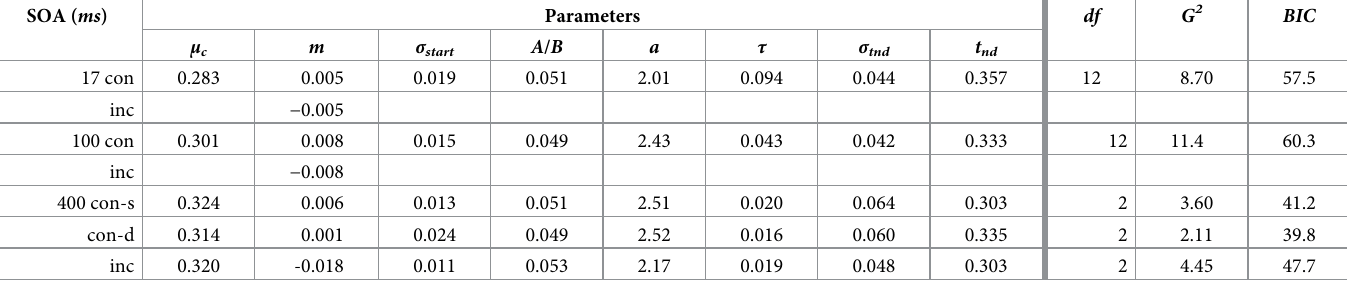
Table 1. Estimated parameters obtained by fitting the DMC model to the data of Experiment 2. SOA ( ms )